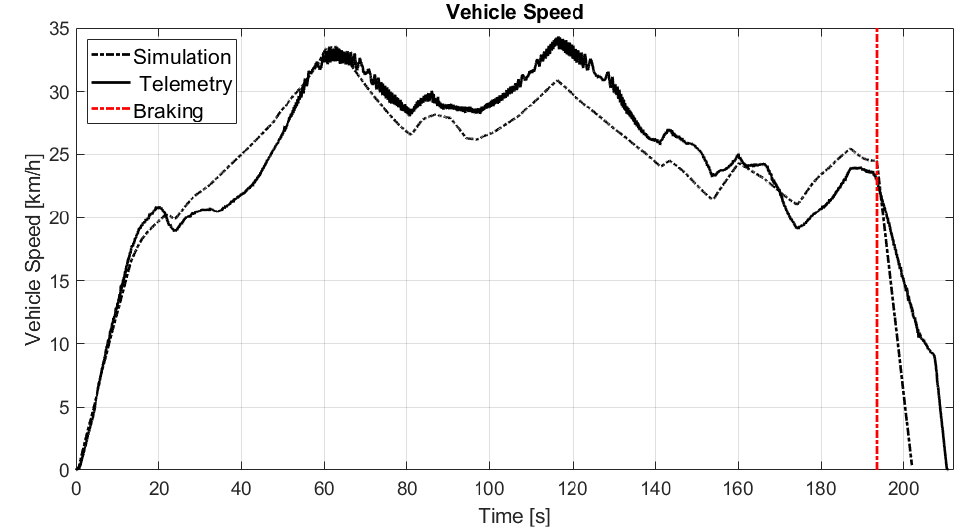
Figure 7. Comparison the simulated and recorded vehicle speed for model validation.